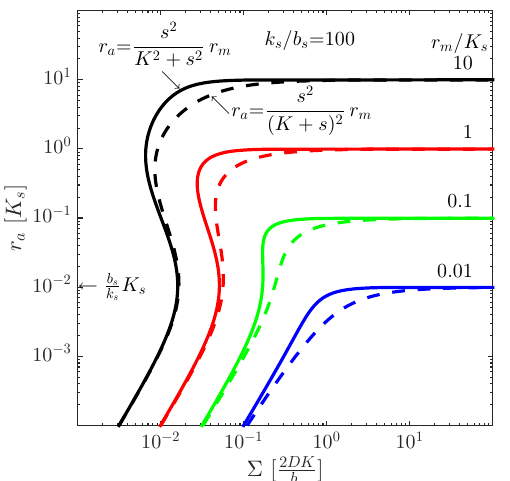
Figure 4. Intracellular concentration of the activated regulator at the center of a bacterial colony as a function of the colony size. The full curves represent cooperative ligand binding, and the dashed curves represent independent binding. When r to a robust switch is present for cooperative ligand binding, as well as for independent binding. With cooperative binding, the switch is well defined at moderately lower r than obtained with non-cooperative binding. Adapted from [11]—published by The Royal Society of